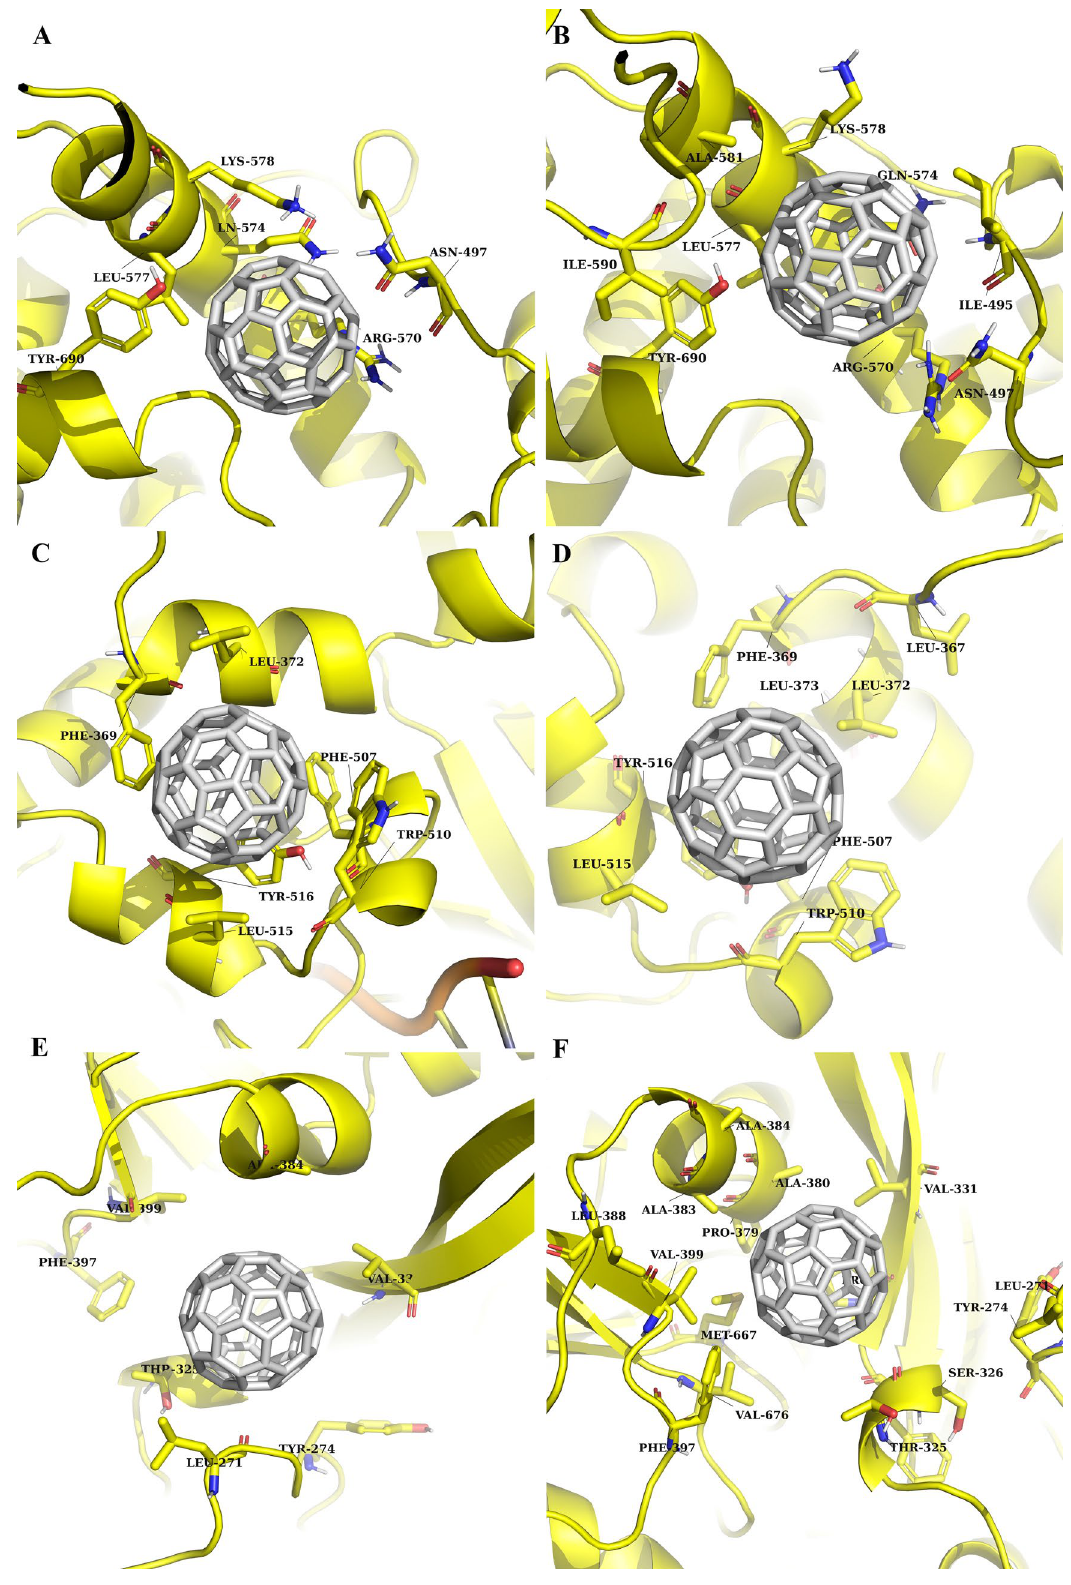
Figure 4. Molecular docking ( A , C , E ) and MD simulation ( B , D , F ) results of complex between C 60 fullerene (in grey) and investigated pockets of RdRp (in yellow): ( A , B )—pocket 1; ( C , D )—pocket 2; ( E , F )—pocket